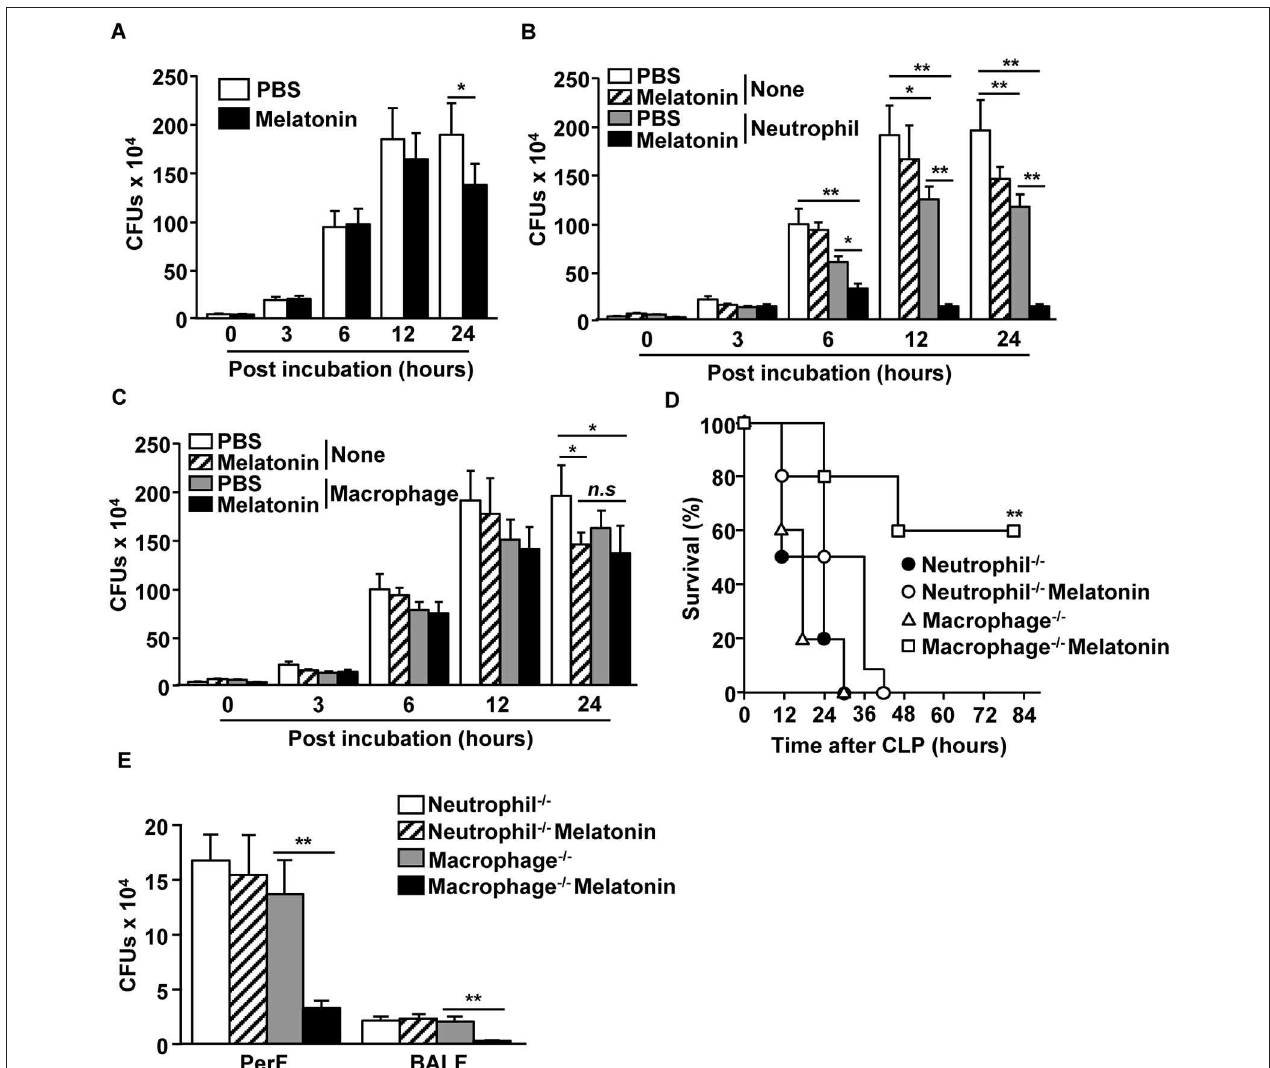
FIGURE 3 | Neutrophils were required for melatonin-induced protection against polymicrobial-infected sepsis. (A) Mixture of E. coli and S. aureus were incubated with 100 µ g/ml of melatonin. Anti-bacterial effect of melatonin was shown. (B) Neutrophils were isolated from the bone marrow, and the neutrophils (0.2 × 10 6 ) were co-cultured with a mixture of E. coli (1 × 10 6 ) and S. aureus (1 × 10 6 ). Numbers of CFUs were measured in the PBS- and 100 µ g/ml of melatonin-treated neutrophils. (C) Isolated macrophages from spleen were assessed for their anti-bacterial effects upon melatonin (100 µ g/ml) treatment. All data are the average of six independent samples. * p < 0.05, ** p < 0.01. (D) Survival rates were monitored after melatonin treatment in neutrophil- or macrophage-depleted mice after CLP surgery. ** p < 0.01, based on ANOVA. Sample size, n = 10 per group. (E) The numbers of CFUs in the peritoneal fluid (PerF) and bronchoalveolar lavage fluid (BALF) were measured 24h after the melatonin treatment and CLP surgery. ** p < 0.01 from six independent